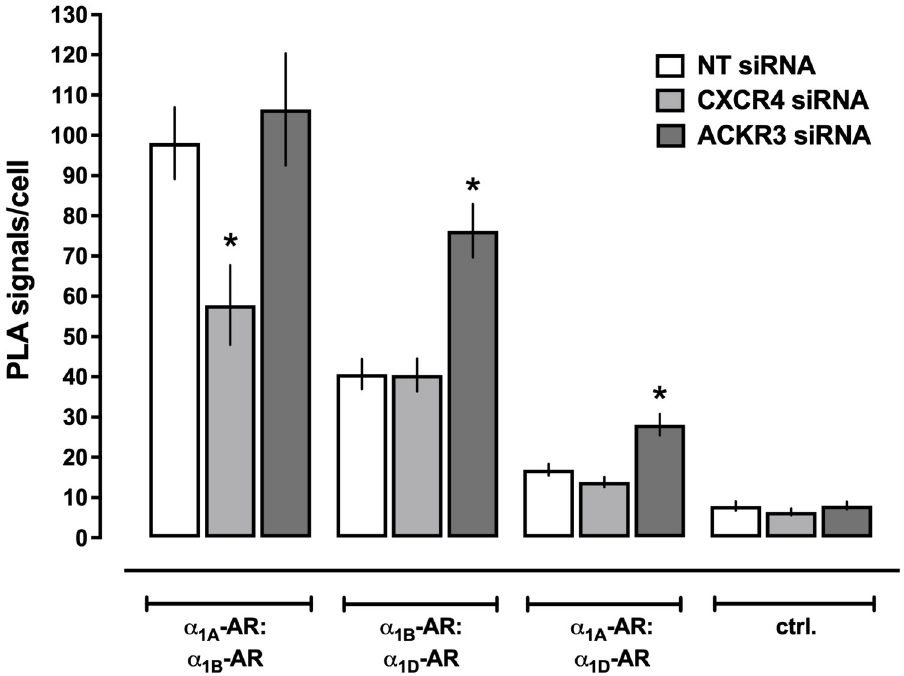
Fig 6. Re-organization of α 1A/B/D -AR heteromers after depletion of CXCR4 or ACKR3 in hVSMCs. Quantification of PLA signals for the detection of receptor-receptor interactions in hVSMCs after incubation with non-targeting (NT) siRNA, CXCR4 siRNA, or ACKR3 siRNA, as in Fig 5. N = 3 independent experiments with n = 10 images per experiment. � : p < 0.05 vs. cells incubated with NT